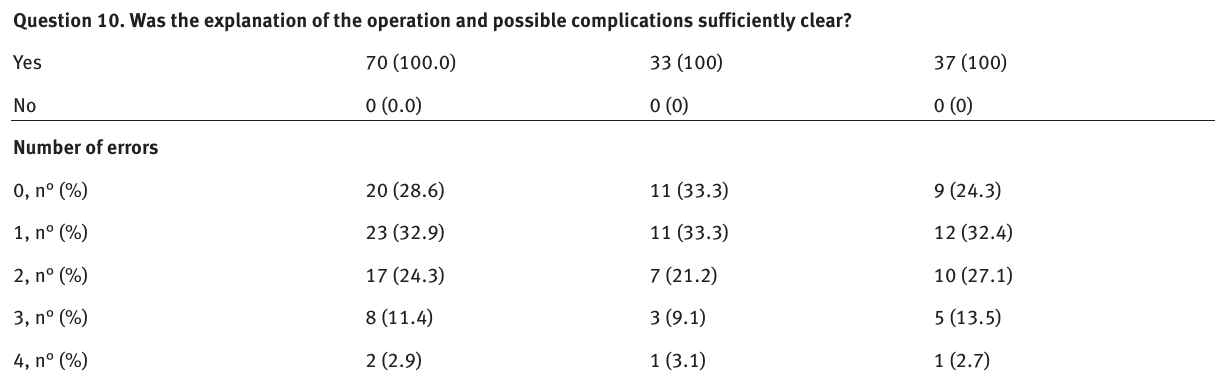
Question 9. What kind of food should be avoided the first days after the operation?